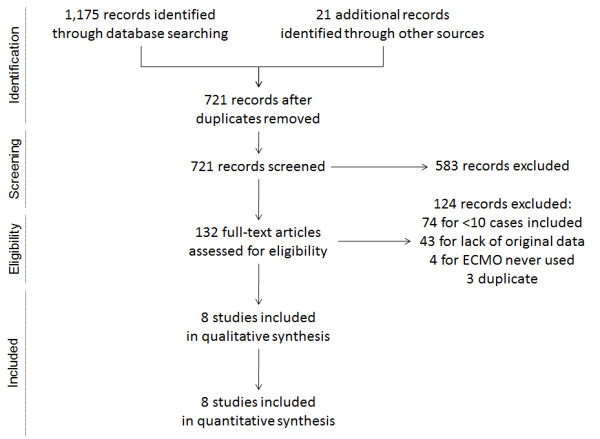
Flow of information through the different phases of a systematic review.